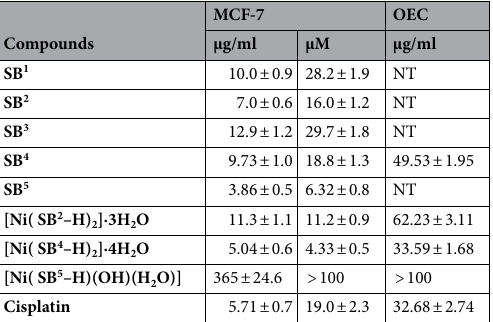
Table 6. Cytotoxicity activity (IC 50 ) in μg/ml and µM of Schiff bases and some of their complexes.